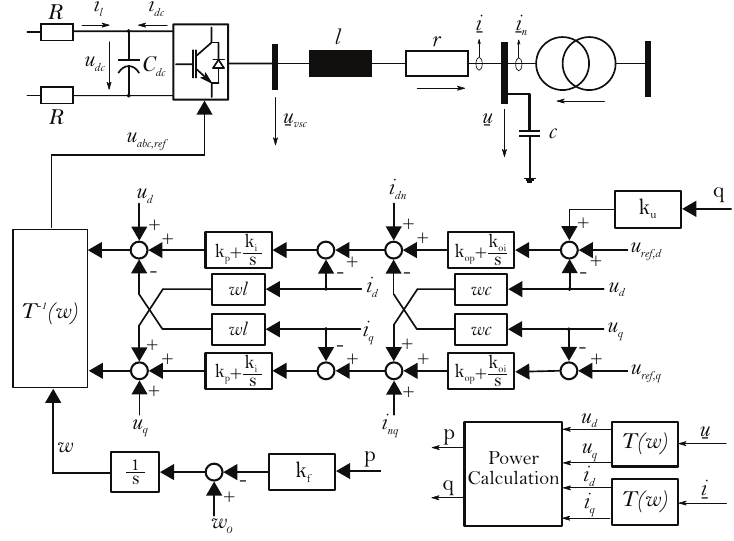
Figure 5. Control block diagram of an offshore side